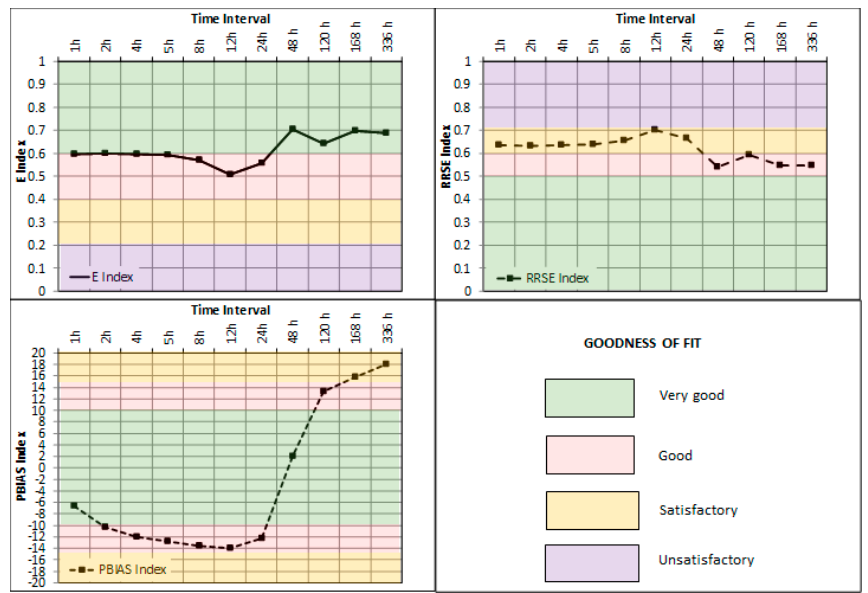
Figure 6. Calibration parameters: goodness-of-fit performance.